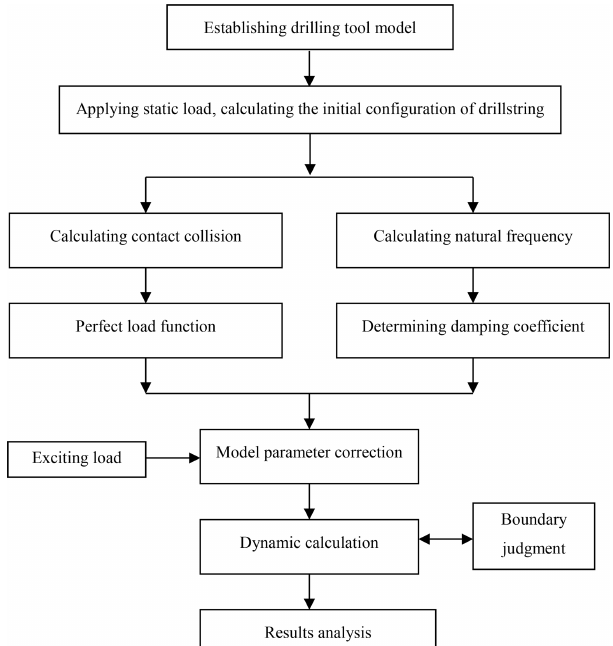
Figure 3. Modal analysis calculation